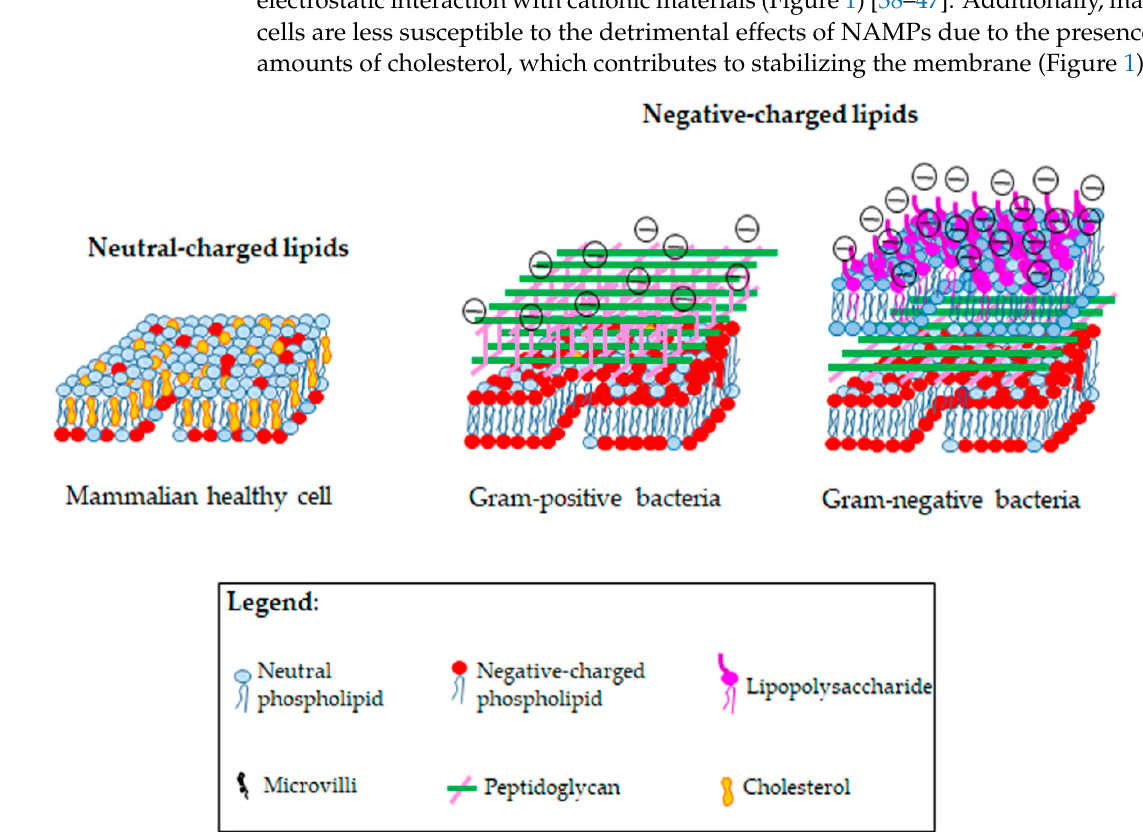
Figure 1. Comparison among membrane lipid composition of healthy mammalian cells, Gram- positive and Gram-negative bacteria.